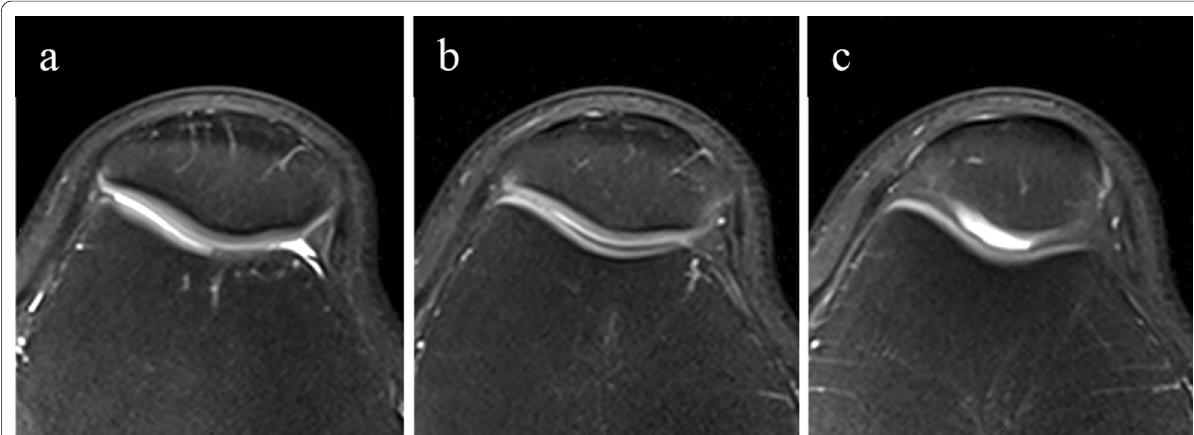
Fig. 3 Illustration of the entrance plane of femoral trochlea, proximal slice and distal slice. a The proximal slice of the entrance plane of femoral trochlea, lateral articular surface showed the presence of cartilage, but the boundary was blurred, and medial articular surface was without cartilage covering. b The entrance plane of femoral trochlea, and it was the first craniocaudal plane where the complete cartilaginous trochlea can be seen. c The distal slice of the entrance plane of femoral trochlea, and the trochlea groove can be seen